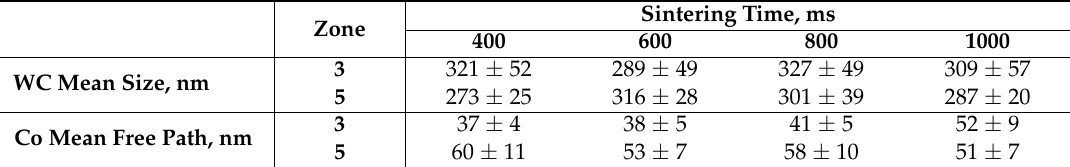
Table 2. Effect of sintering time on WC mean grain size and Co mean free path at zones 3 and 5, measured along a line perpendicular to the pressing direction. All samples were sintered at 9 kA.